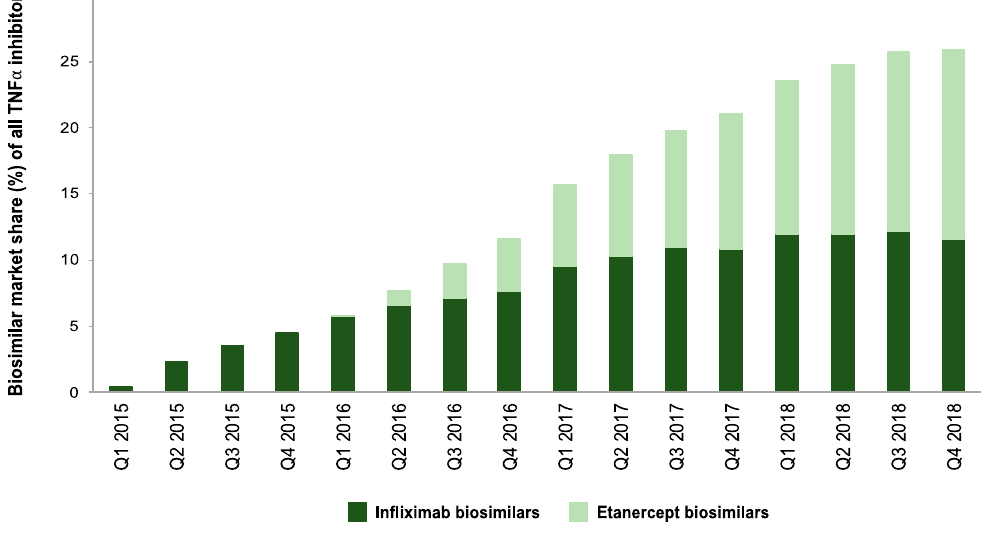
Figure 3. Composition of the market for TNF α inhibitors in terms of biosimilar products (2015–2018). Biosimilar market shares (%) for infliximab and etanercept are calculated in relation to the total volume of TNF α inhibitors.